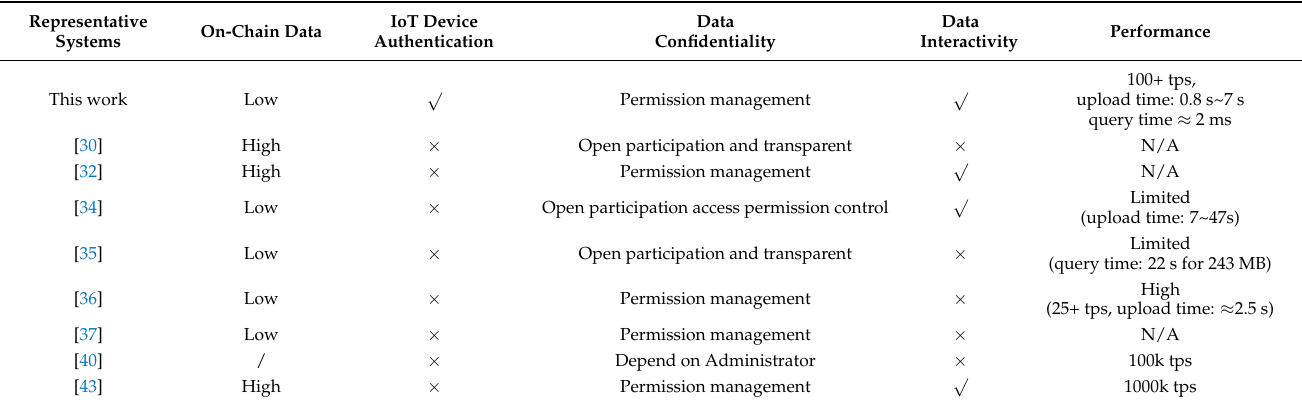
Table 8. Comparison between the proposed system and the other related